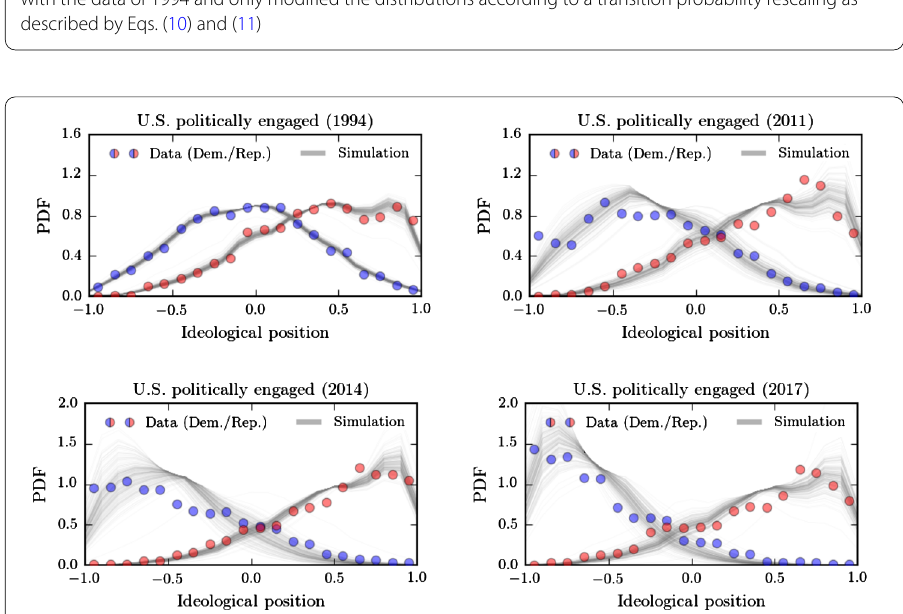
Figure 5 Polarization in the U.S. politically-engaged public in comparison with our model. For the U.S. politically engaged public, we show the ideology distributions for Democrats (blue disks) and Republicans (red disks). The dataset is based on a survey conducted by Pew Research Center (see [6] for details). We initialized our model (grey solid lines) with the data of 1994 and only modified the distributions according to a transition probability rescaling as described by Eqs. (10) and